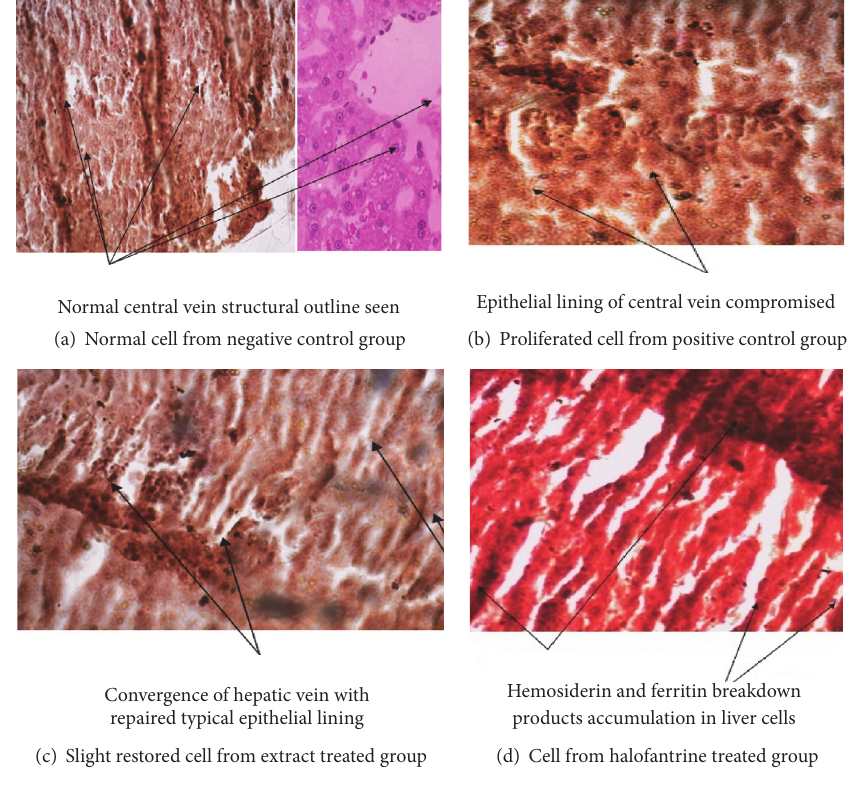
Figure 3: Representative central vein of the hepatic cells of the parasitic mice treated with leaf extracts of V. amygdalina, C. papaya, and